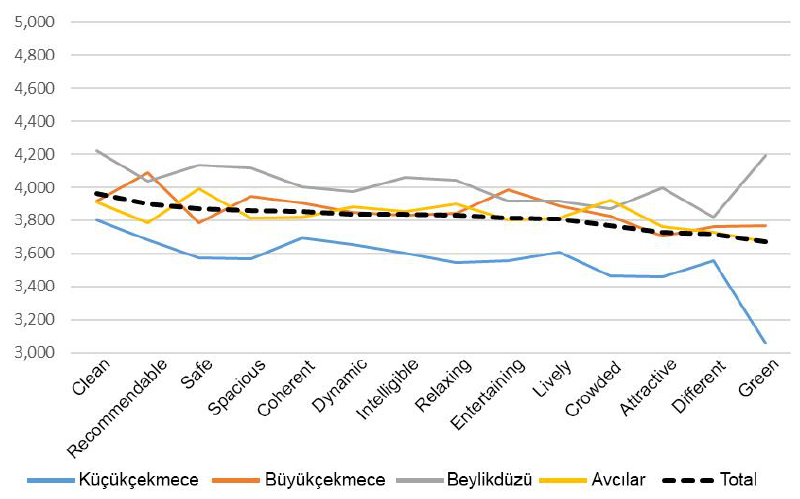
Figure 7 Participants' evaluation based on the survey. Lines show the average of the rates (higher scores show higher satisfaction level).